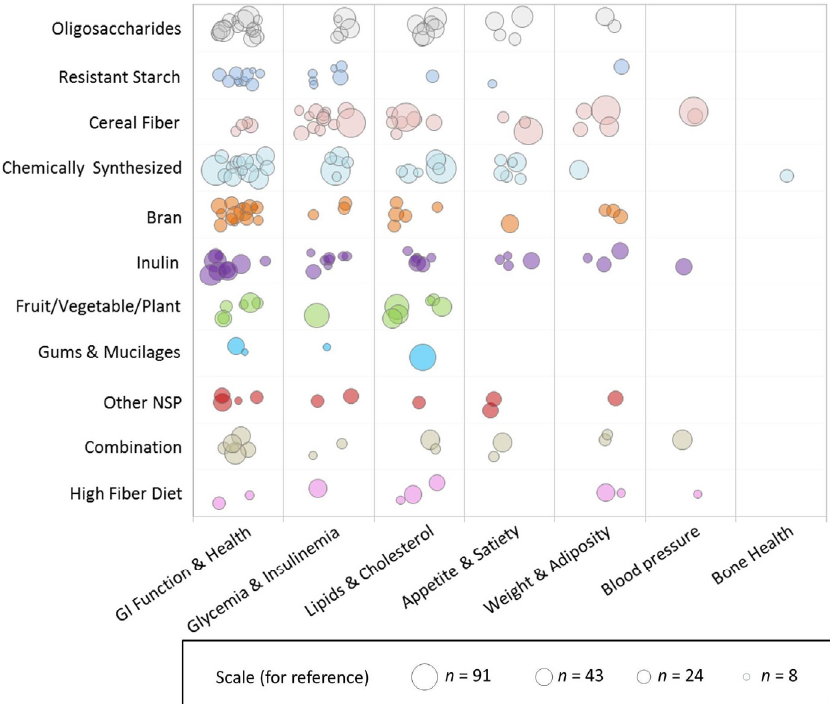
Figure 2. Weighted scatter plot of other physiological health outcomes by fiber group. Each bubble in the plot represents a single publication with the size of the bubble corresponding to the study sample size. Studies may be represented more than once throughout the plot if multiple fiber interventions or outcomes were reported but are not repeated within any single cross ‐ sectional area. Note that the outcome effect is not represented in this graphic, i.e., this does not reflect the effect of the fiber on the outcome.